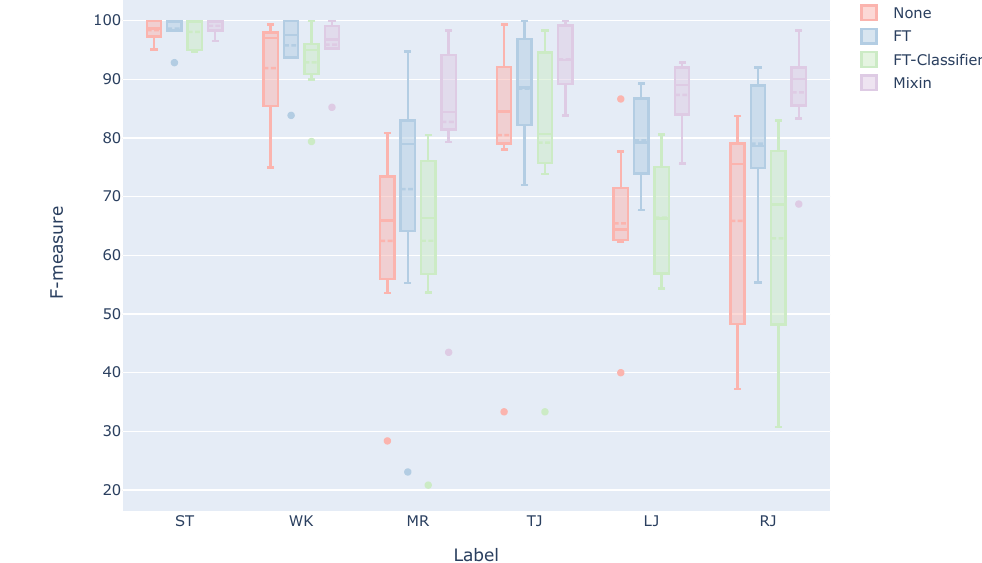
Figure 7. F-measure for each estimation target when using the user data for